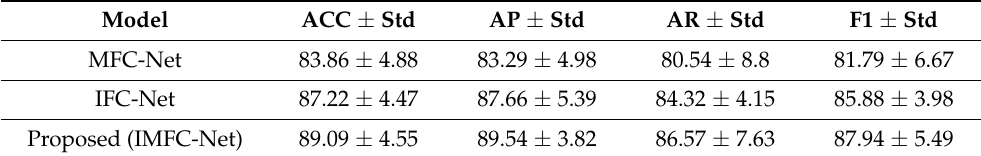
Table 2. Performance comparison of the submodules with that of the proposed model using the shoulder implant dataset. (ACC: accuracy, AP: average precision, AR: average recall, F1: F1.score, Std: standard deviation, unit: